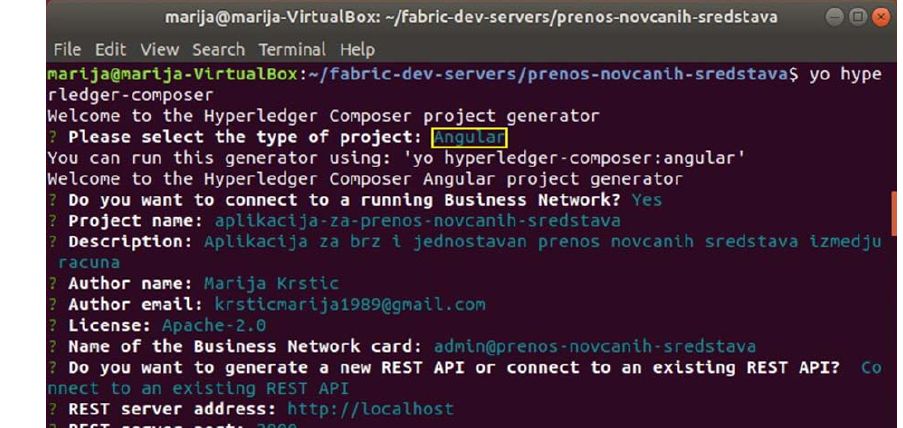
Figure 4 – Successfully generated application Рис . 4 – Успешно созданное приложение